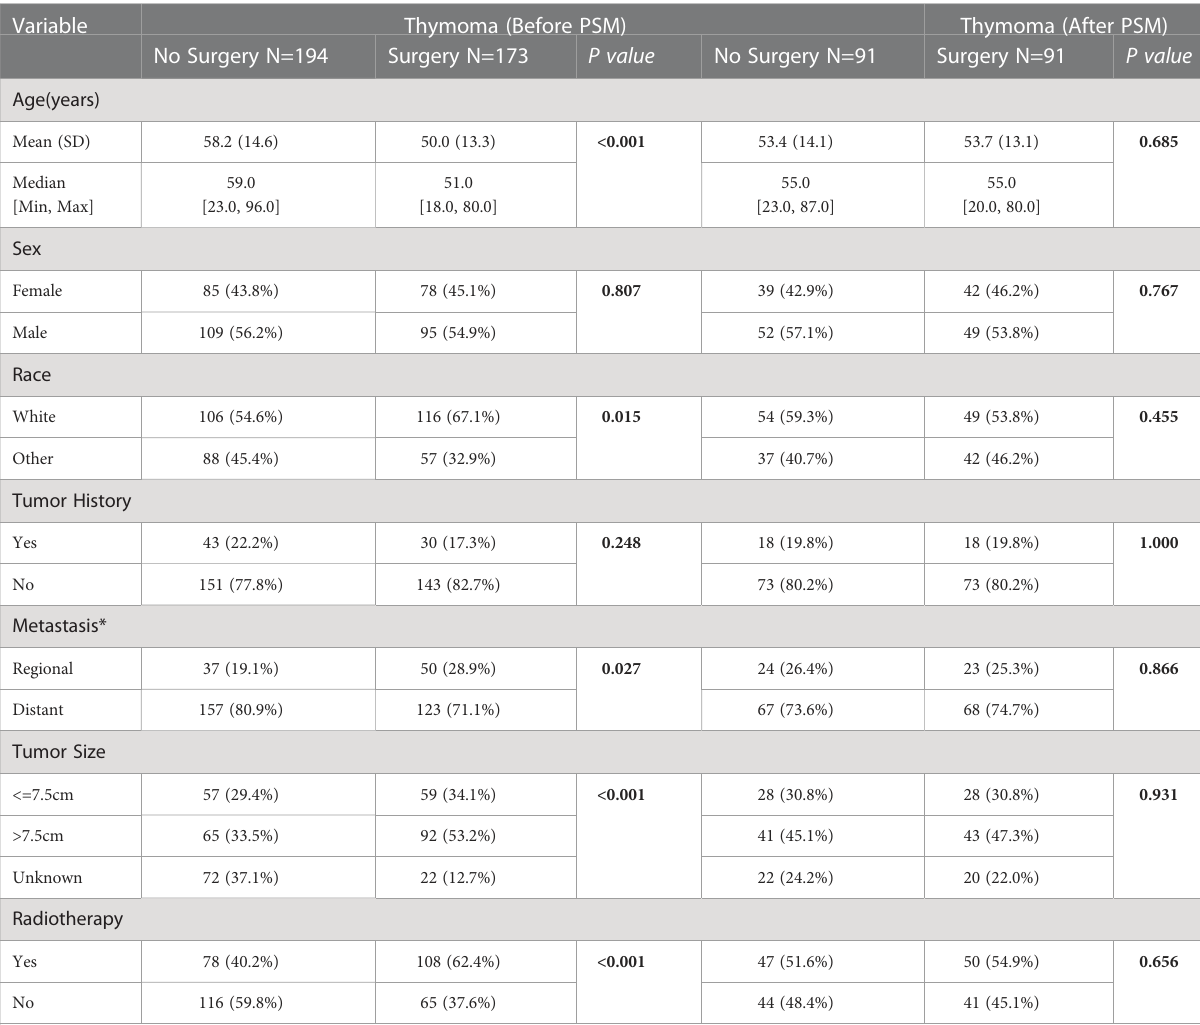
TABLE 2 The information on before and after PSM in patients with